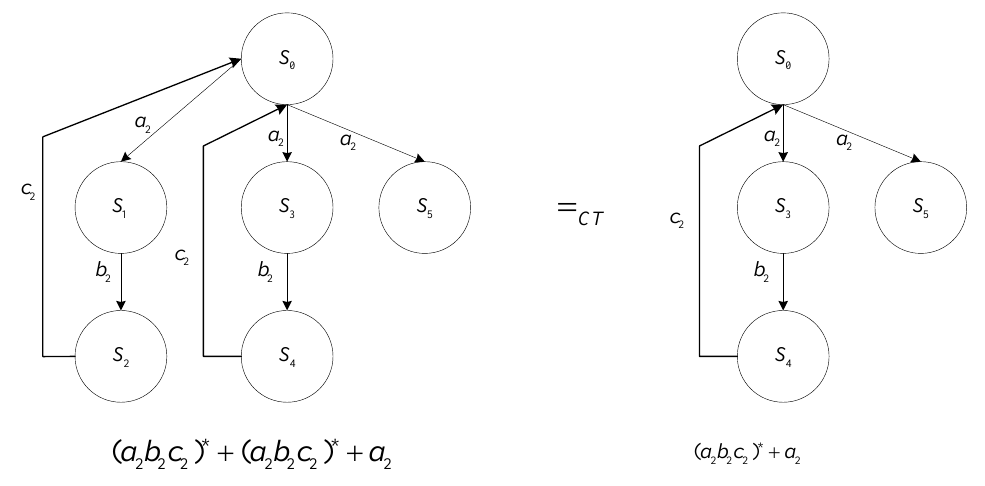
Figure 5. A completed trace equivalence